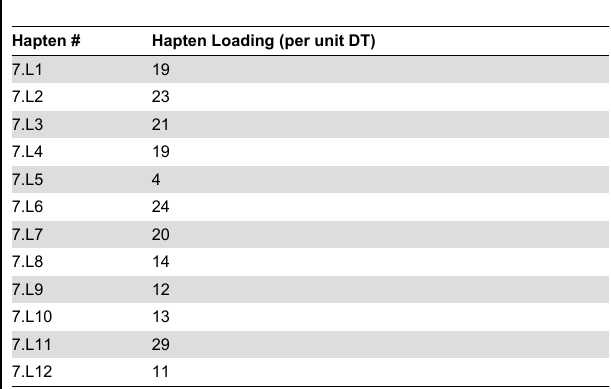
Table 2. Hapten Loading of Different Hapten 7-DT Conjugates.